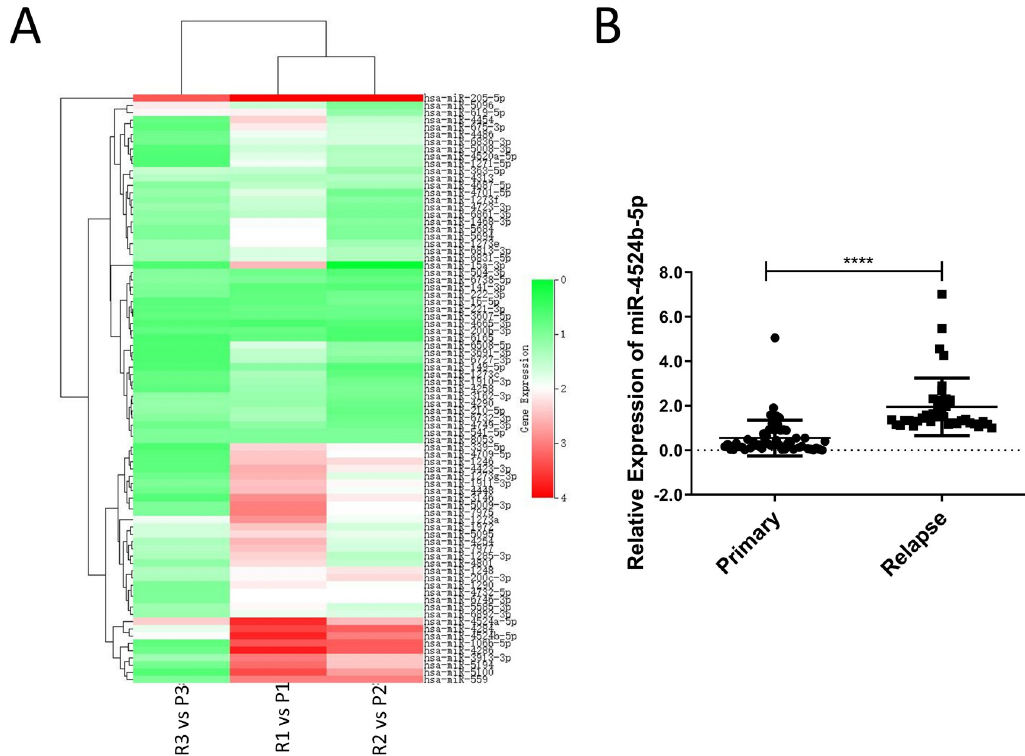
Fig 1. MiR-4524b-5p expression is higher in relapsed cervical cancer specimens than in primary specimens. (A) Heatmap analysis the expression of 81 miRNAs in relapsed and primary cervical cancer tissues; hsa-miR-4524b-5p expression is higher in relapsed cervical tissues (R: relapsed; P: primary). (B) Compared with primary cervical tissues (n = 50), miR-4524b-5p is significantly increased in relapsed cervical tissues (n =